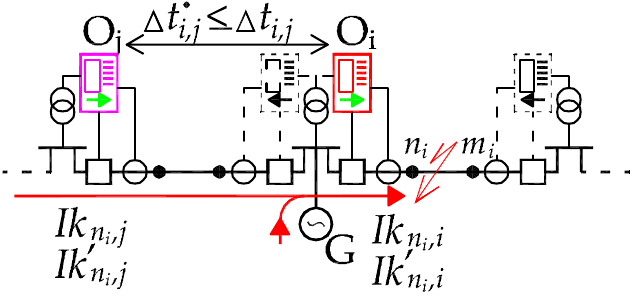
Figure 4. Fault path definition.